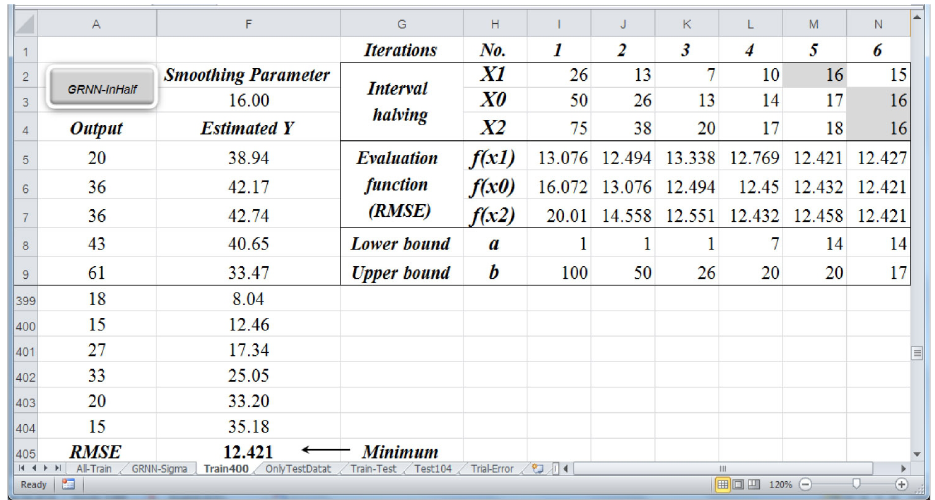
Figure 5. Output screen capture of the accuracy improvement module using the interval halving method